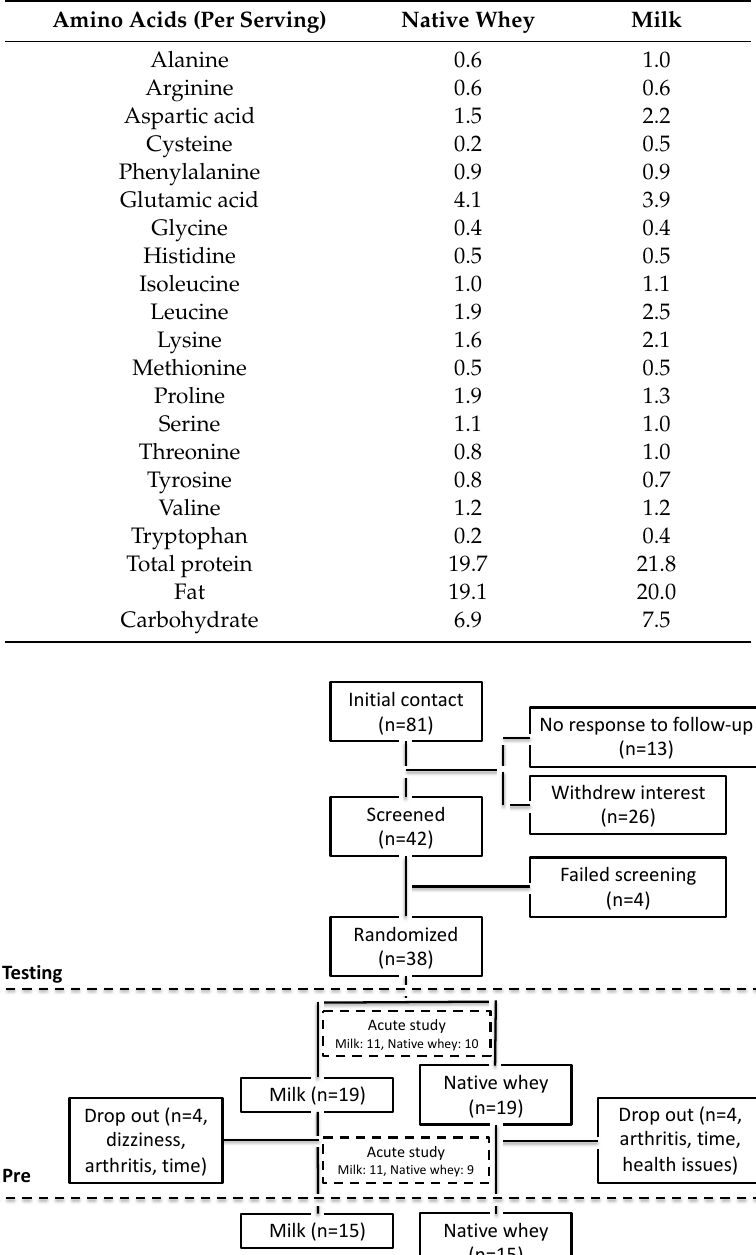
Table 1. Amino acid and macronutrient content of the supplements.